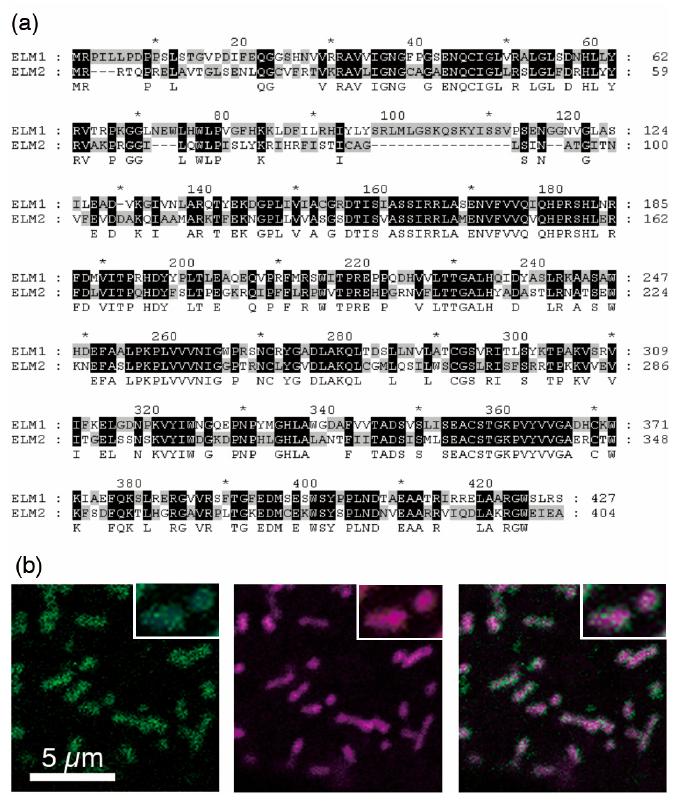
Figure 2. ELM2 encodes an ELM1-like protein and GFP-tagged ELM2, like ELM1, localizes to the mitochondrial surface. ( a ) Clustal W alignment of ELM1 and ELM2 amino acids sequences. * depicts the positions of numbers in every ten amino acids. ( b ) Localization of GFP-ELM2 surrounding mitochondria. Arabidopsis cultured cells transiently expressing GFP-ELM2 with a mitochondrial marker MitoTracker were examined by confocal laser scanning microscopy (CLSM). A part of a single cell is shown. Left and Center are separate images obtained with the GFP and MitoTracker, respectively. Right is the merged image. Scale bar, 5 μ m, is applicable to the other two figures. Upper right insets are X2 enlarged images.